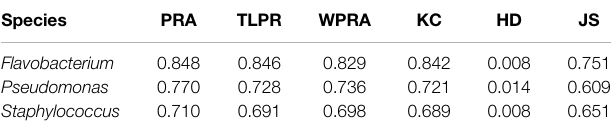
TABLE 1 | Performance under 5-fold cross-validation for the three genera.